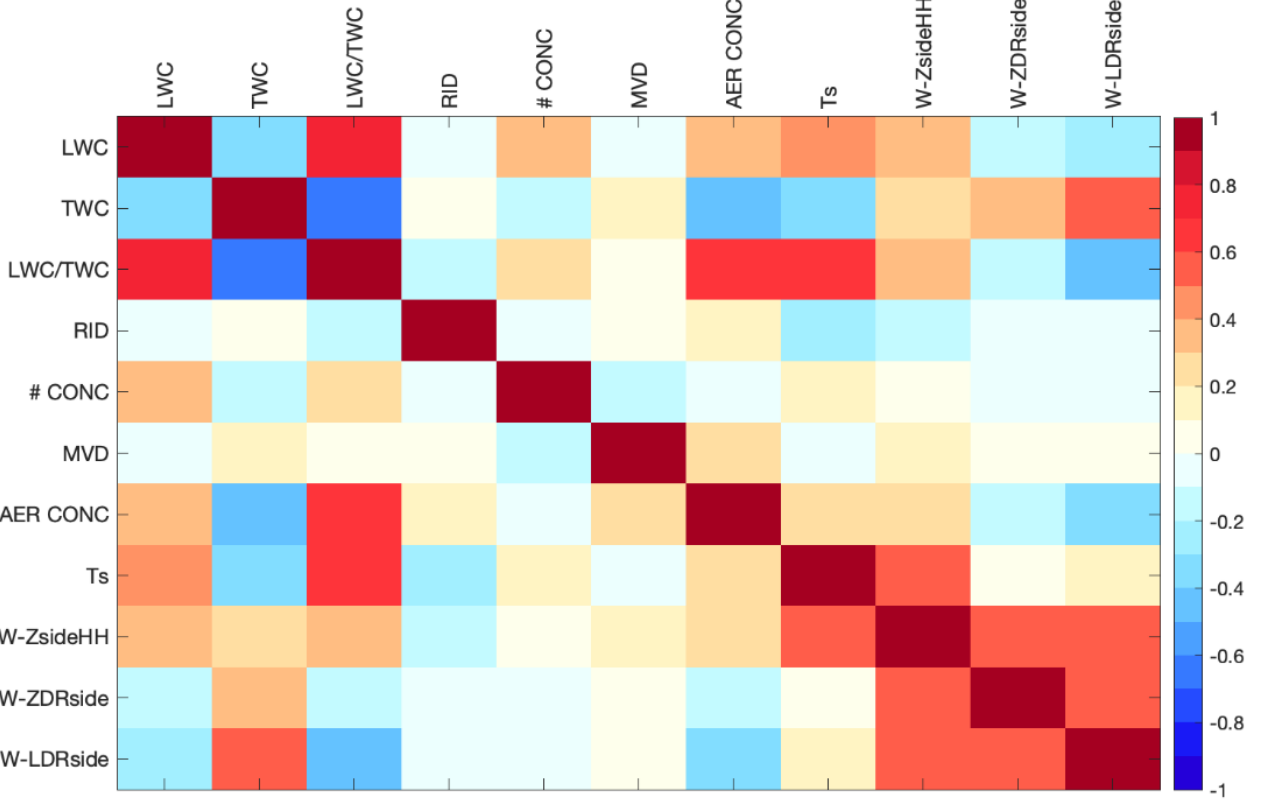
where N i and D i are the number concentration and middle point of the i -th size bin, re- spectively. The size distribution of the hydrometeors has a direct impact on the W-band radar variables, recorded using the side-pointing antenna (see Section 2.1.1). In order to avoid unreliable and noisy signal, all three radar variables (i.e., Z, ZDR, LDR) were masked us- ing a SNR threshold of 0 dB. Differential reflectivity exhibited close range biases within 1- km distance from the aircraft (not shown) and was calibrated using flight segments in small liquid drops, where ZDR is approximately 0 dB. Further steps in data preparation addressed the issue of missing values. Keeping missing input values (e.g., NaN, Inf) induces large voids in each input parameters dataset, which will remain unclassified, a scenario that would lead to a larger data void in the clustering product because of the overlap of multiple input datasets. A common practice is to fill the gaps in observations with the mean of the non-missing values or some prede- fined constants. However, such data manipulation does not work well and in most cases will likely result in the ‘cloud’ class inflation during the time intervals when the instru- ment was legitimately not in operation, or the signal was below its sensitivity threshold and hence could not be detected. Rather than ignoring missing data in the input dataset or replacing it with mean values, we impute the missing values for each input variable, independently, according to the following procedure: LWC, TWC, aerosol concentration,